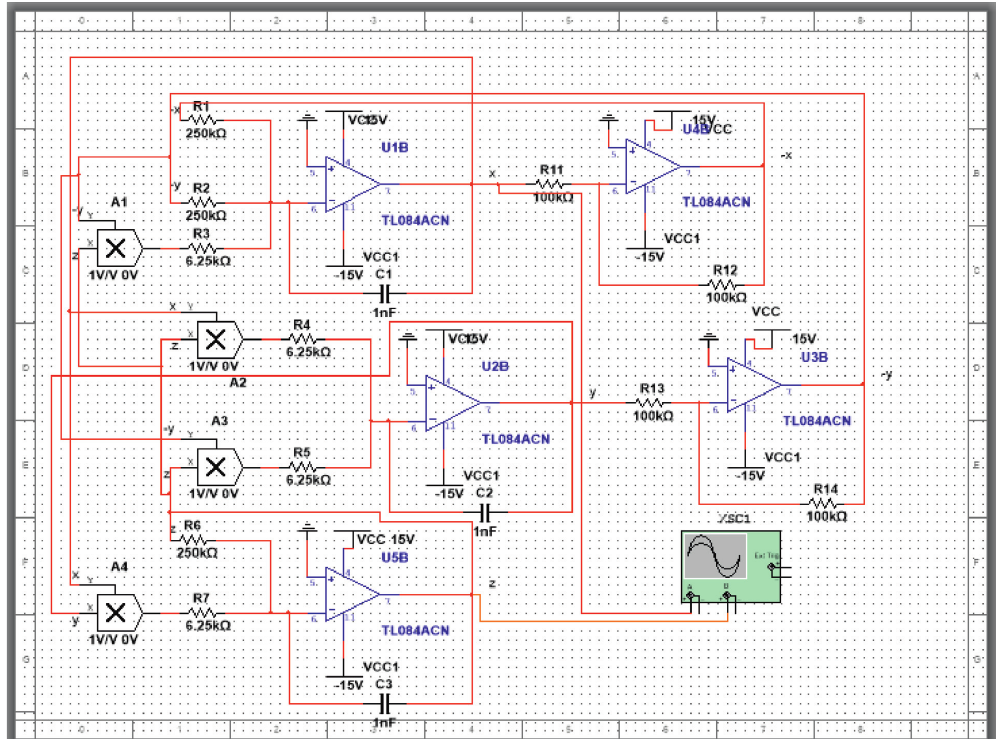
Figure 17: Circuit schematic for system (57)–(59).